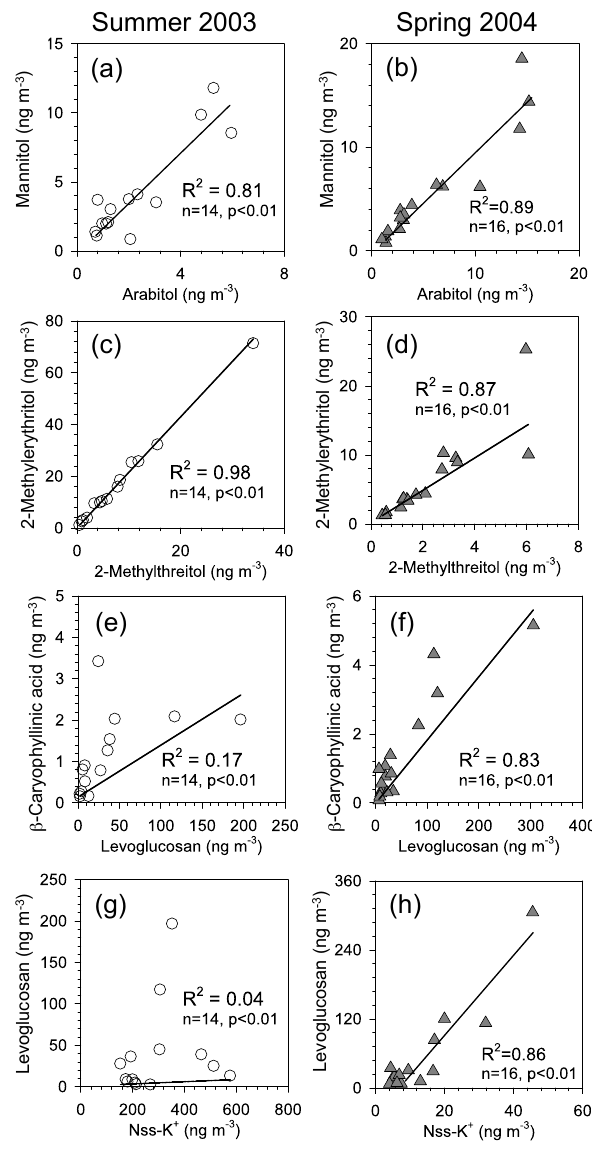
Fig. 6. Relationships between the concentrations of the chemical species identified in the aerosol samples. Circles represent the sam- ples collected in summer 2003 (left), while triangles represent those collected in spring 2004